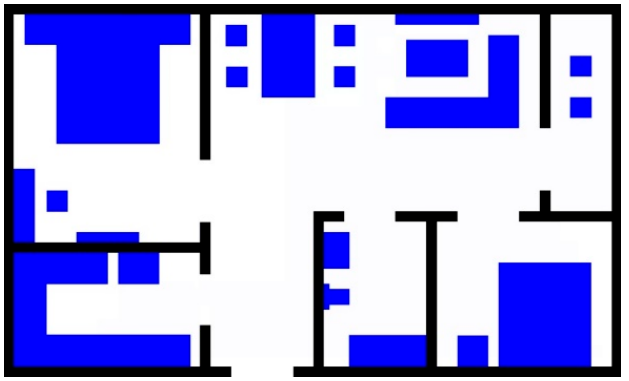
Figure 1. The floor plan of the mock apartment.